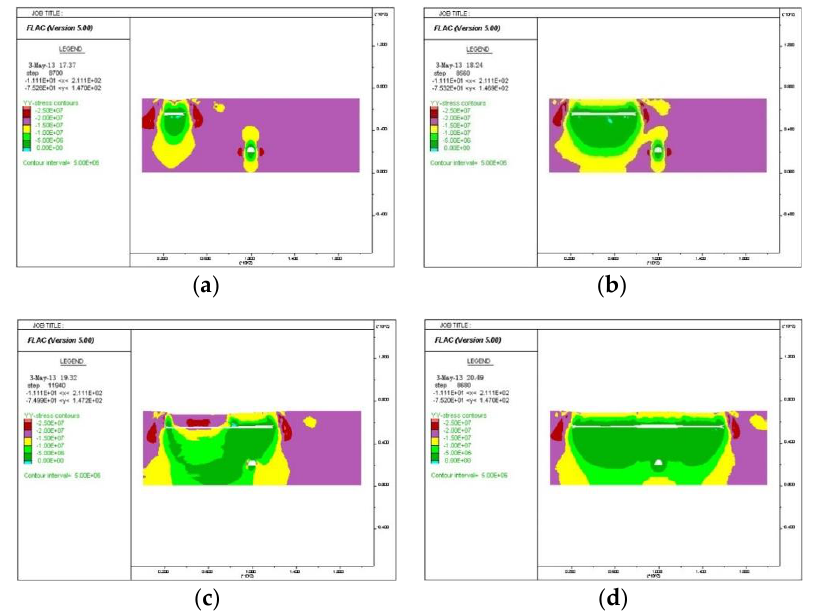
Figure 12. Vertical stress distribution of roadway surrounding rock during bolt support. ( a ) Working face is 60 m away from the roadway. ( b ) Working face is 20 m away from the roadway. ( c ) Working face spans the roadway 20 m. ( d ) Working face spans the roadway 60 m.